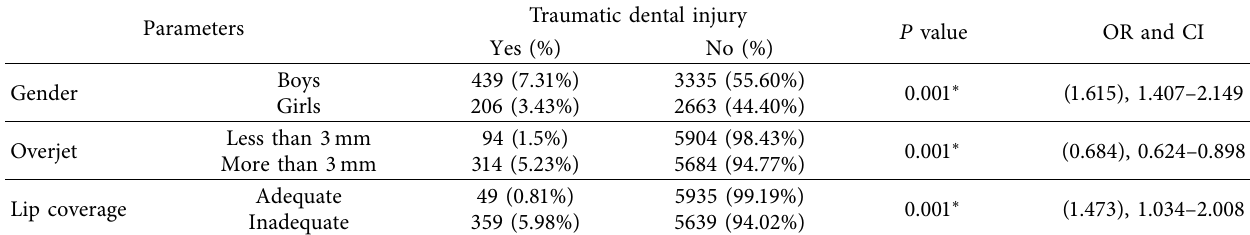
Table 6: Multiple logistic regression analyses of gender, size of the incisal overjet, and type of lip coverage for TDI.